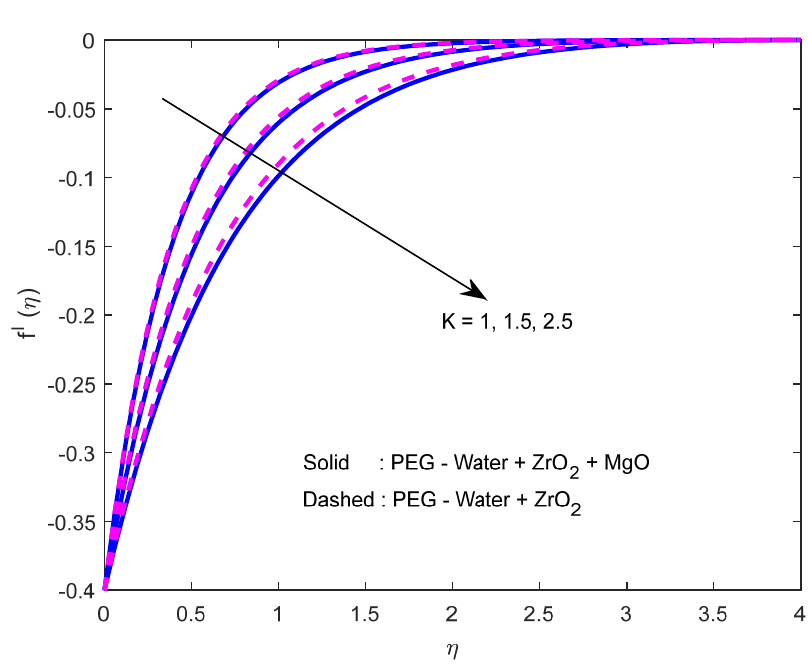
Figure 10. Effects on velocity due to K .